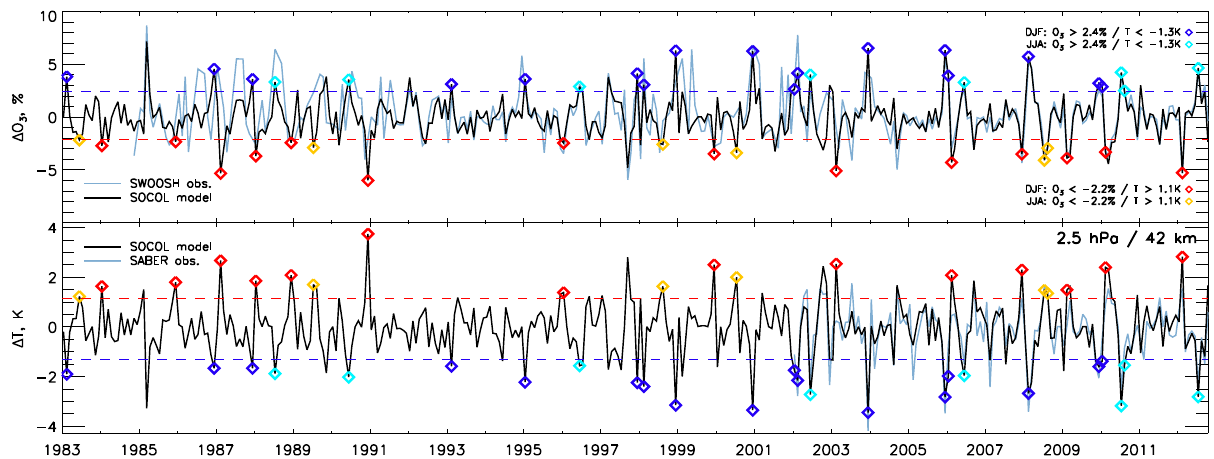
Figure 1. Monthly anomalies of equatorial (20 ◦ S–20 ◦ N) ozone (upper; %) and temperature (lower; degrees Kelvin) at 2.5hPa, following the subtraction of 13-month box-car smoothing and monthly deseasonalising from the CCM SOCOL model in specified-dynamics mode. SWOOSH ozone composite time series and SABER temperature measurements are shown in light blue in the upper and lower plots, respec- tively. The dashed blue and red horizontal lines are the thresholds shown in Fig. 2; thresholds for each coloured diamond are given in the right of the upper panel. June–July–August (JJA) anomalies exceeding the thresholds have orange (high T ) and turquoise (low T ) diamonds;